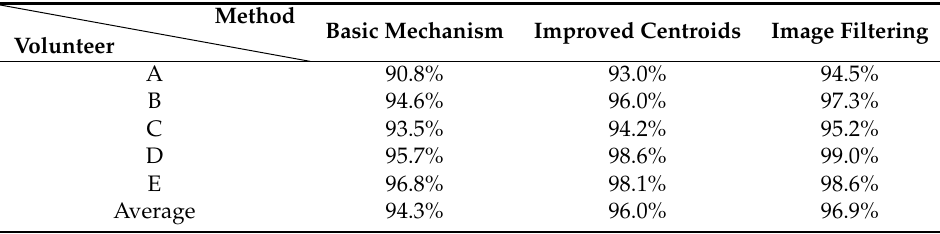
Figure 10. Number of images that are filtered by volunteers and the image filtering algorithm simultaneously. Table 6. Classification accuracies with different